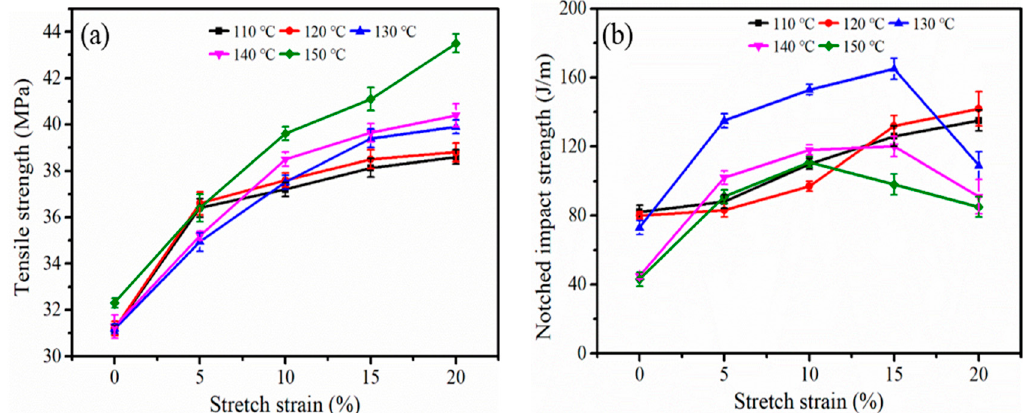
Figure 9. The tensile strength ( a ) and the notched impact strength ( b ) of the iPP sheet after stretching at different temperatures.